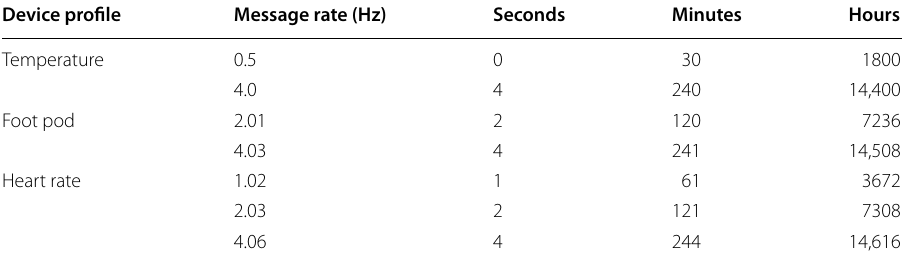
Table 6 Data messages cardinalities with respect to allowable message rates Device